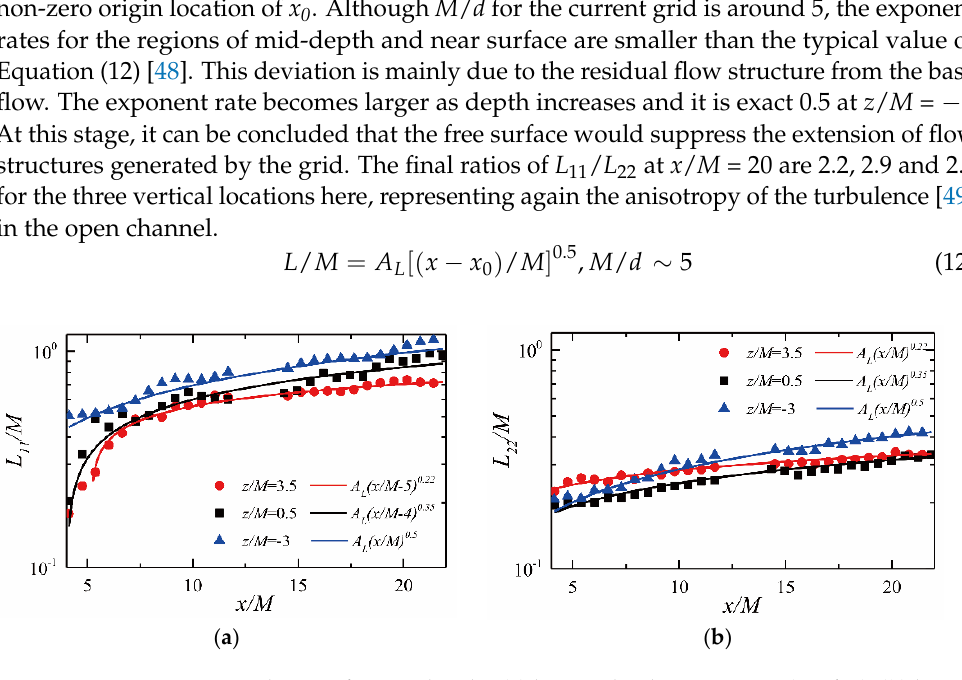
Figure 15. Stream-wise evolution of integral scales ( a ) longitudinal components ( L 11 / M ); ( b ) lateral components ( L 22 / M ) at various depths and the corresponding fitting results, red lines (at z / M = 3.5), black lines (at z / M = 0.5), blue lines (at z / M = − 3).